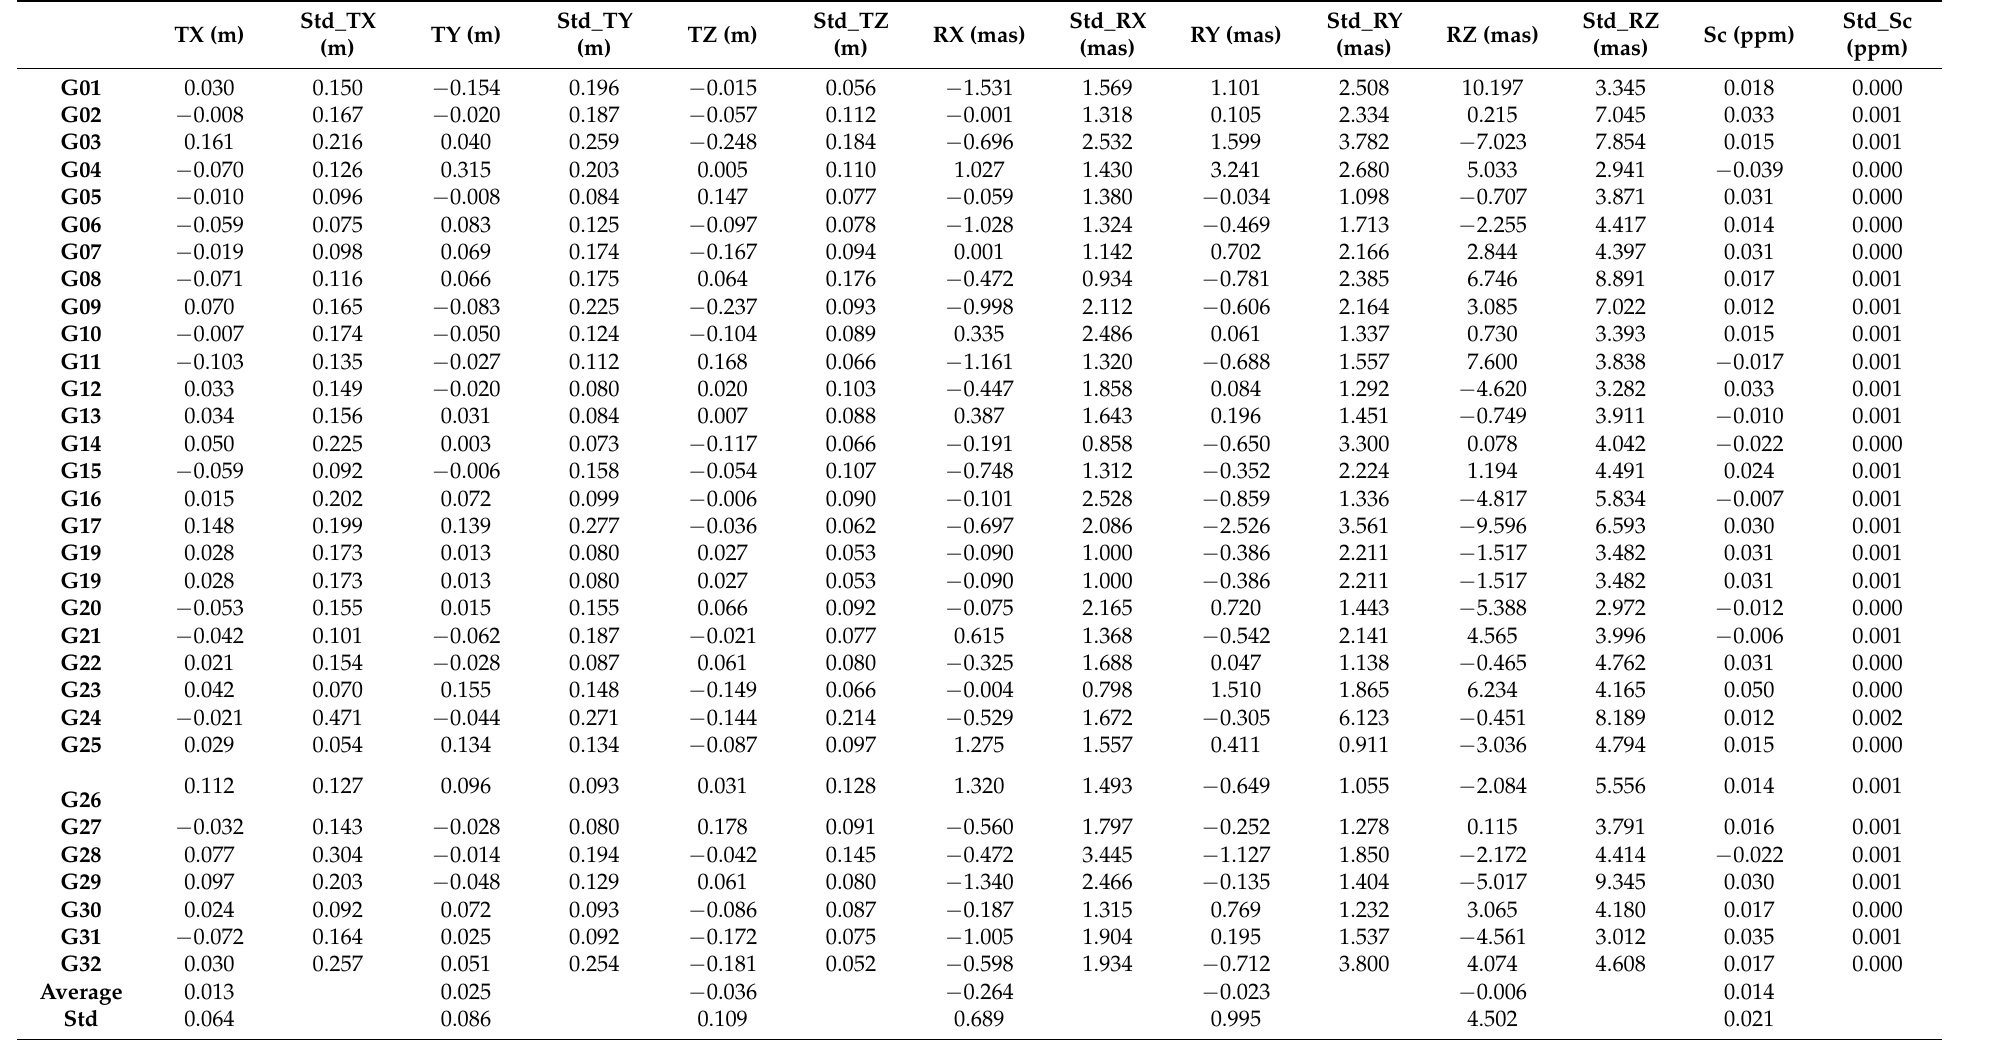
Table A1. Helmert parameters relating the GPS broadcast reference frame to the ITRF2014 Reference frame of the precise ephemeris of CNES. Average values for January